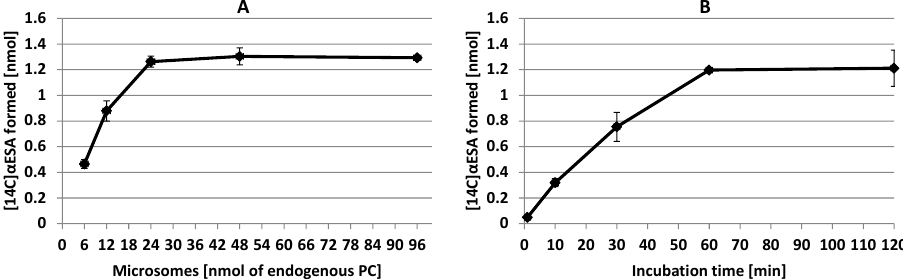
Figure 5. The impact of different amounts of microsomes ( A ) and incubation time ( B ) on the effec- tiveness of αESA biosynthesis by microsomal fraction of developing seeds of Momordica charantia . Assay conditions: 10 nmol [ 14 C]18:2-CoA, BSA (4 mg/mL), NADH (4 mM); incubation time: ( A ) 60 min, ( B ) as indicated in the figure; aliquots of microsomal fractions: ( A ) as indicated in the figure, ( B ) 24 nmol endogenous PC. Mean values and standard deviations ( n ≥ 2 ) are presented.